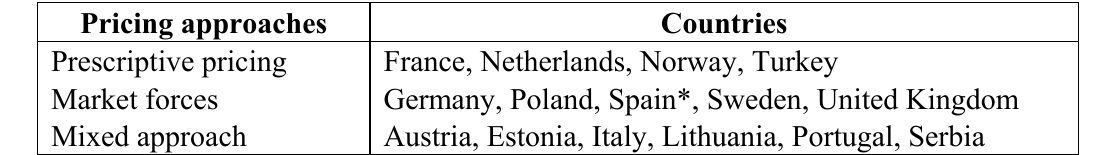
Table 1. Different pricing approaches for generics and originators among exemplar European